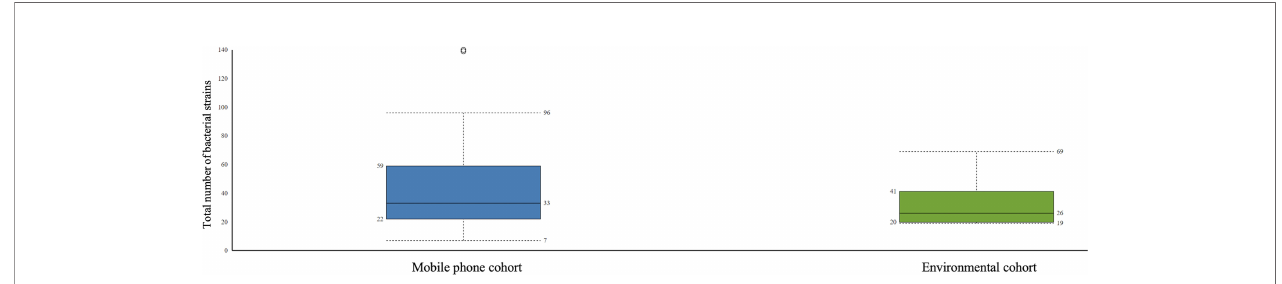
FIGURE 1 | Boxplot representation of the statistics of bacteria strains found in the mobile phone cohort versus the environmental cohort. Interquartile ratio values of 37 and 21 de fi ned the number of bacteria strains in mobile phone cohort and the environmental